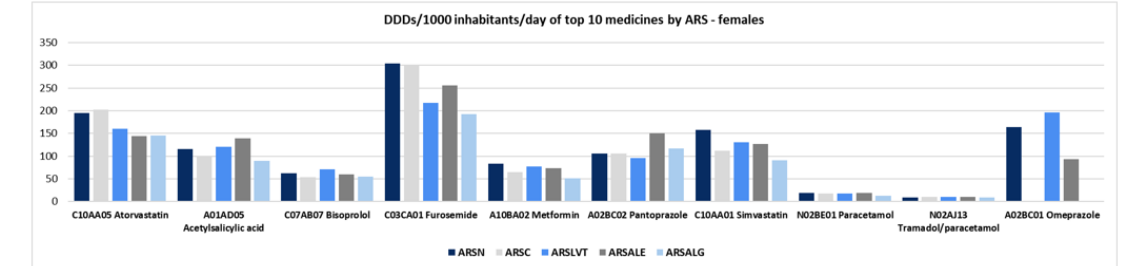
Figure 3. Defined daily dose (DDD) per 1000 inhabitants per day in top-10 level 5 ATCs by health administrative region (ARS) in females. Legend: ARS — North (ARSN), Centre (ARSC), Lisbon-Tejo Valley (ARSLVT), Alentejo (ARSALE), Algarve (ARSALG).